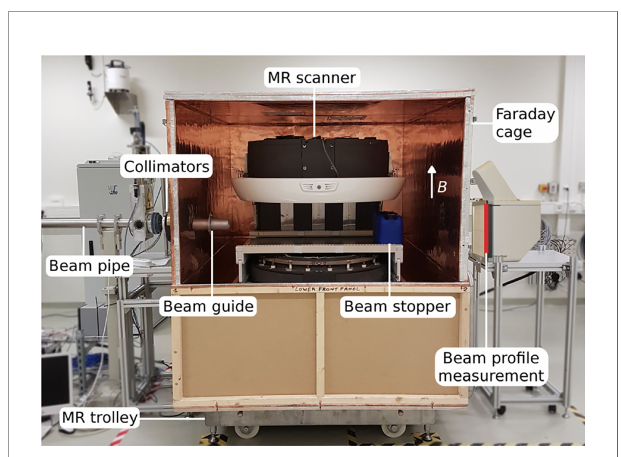
FIGURE 7 | The prototype MR-integrated proton therapy system at the fi xed horizontal beam line in the experimental room of the Dresden proton therapy system – after (65, 66).